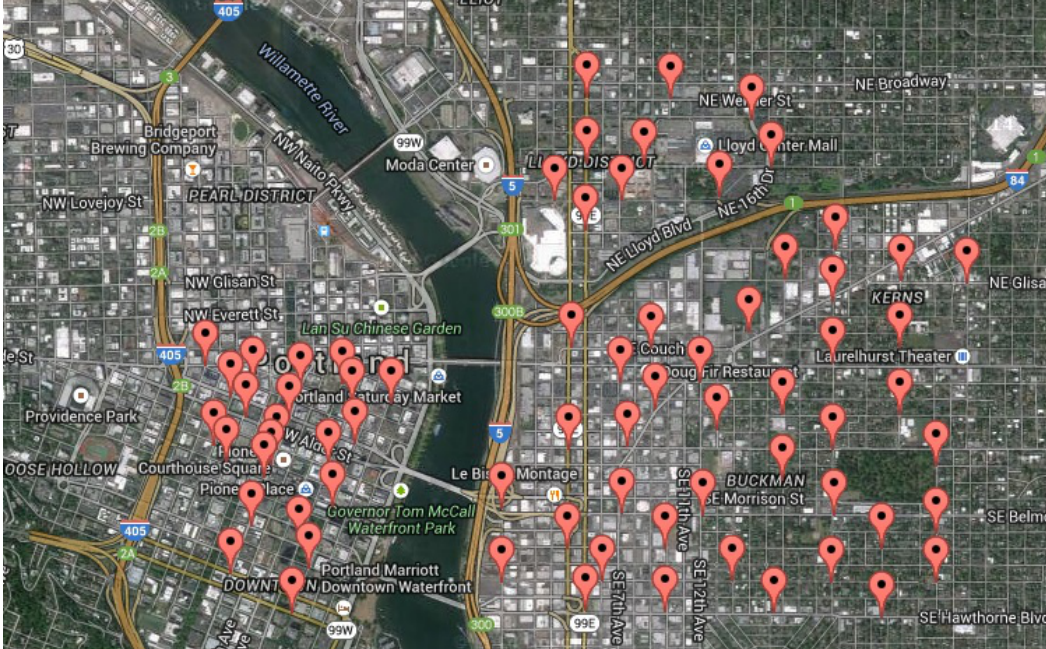
Figure 5. Geographical location of Portland network